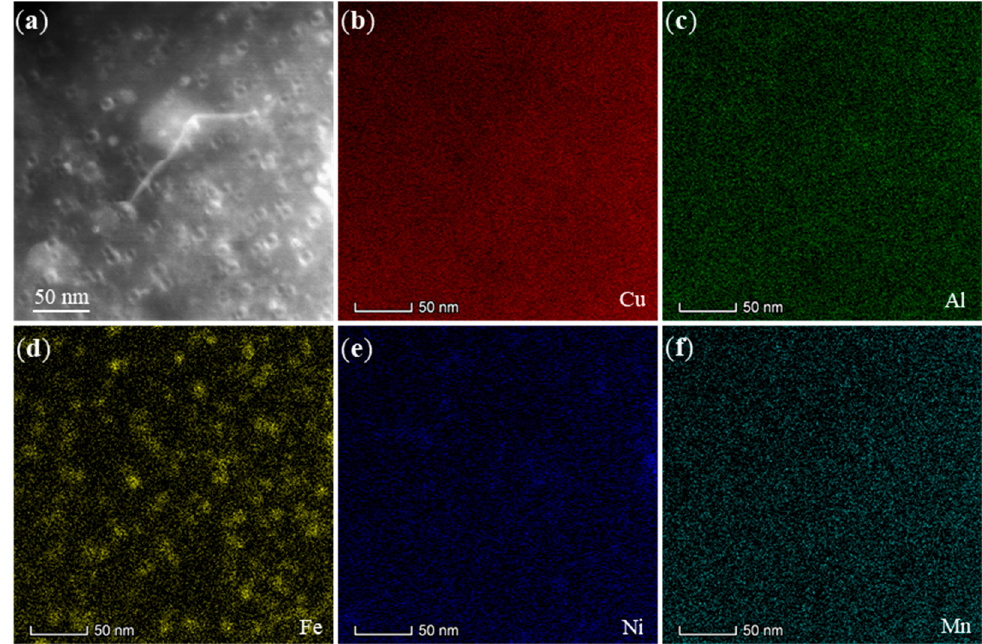
Figure 9. ( a ) HAADF image of the UVA treatment WAAM in the α -Cu matrix region, ( b – f ) corresponding EDS elemental maps for Cu, Al, Fe, Ni, and Mn, respectively. The precipitates are Fe-rich ( κ IV ) in the α -Cu matrix.